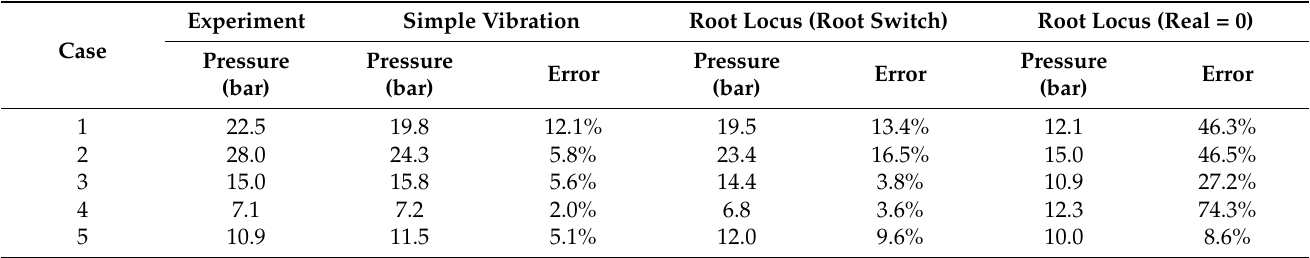
Table 5. Comparison of experiments with two dynamic model predictions for all the cases 1–5: operating frequency.